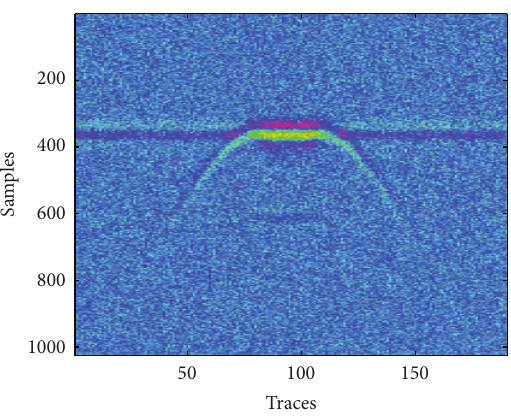
Figure 12: Preprocessing result of raw radargram of